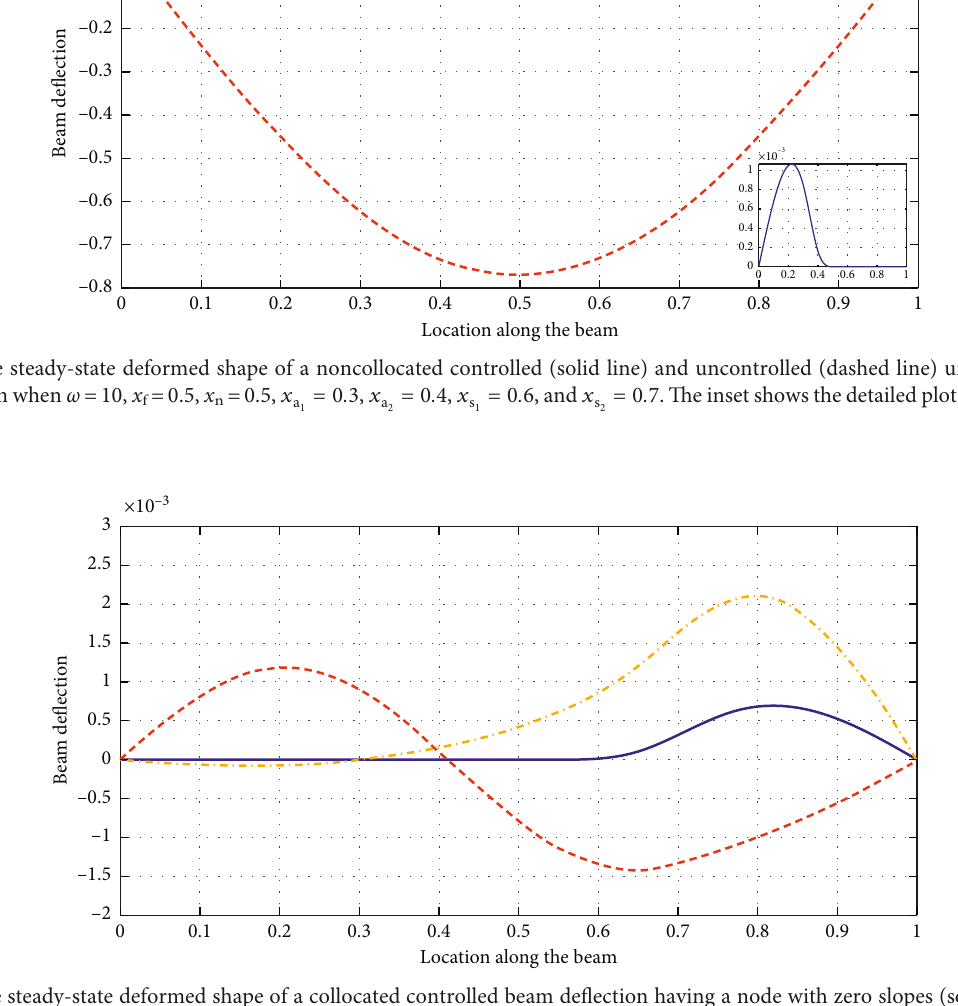
Figure 16: The steady-state deformed shape of a collocated controlled beam deflection having a node with zero slopes (solid line), a node (dashed dotted line), and uncontrolled beam deflection (dashed line) for the undamped simply supported beam when ω � 57, x f � 0.77, � 0 . 65, and x � 0 . x n � 0.31, x a 1 a 2